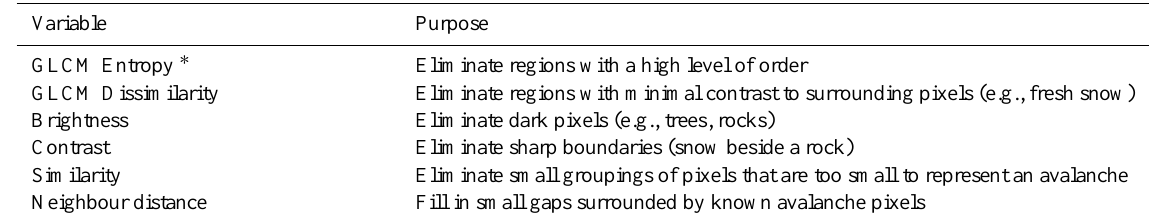
Table 2. Variables used in algorithm developed in eCognition for the automated detection and 249 mapping of snow avalanches in VHR panchromatic imagery. ( ∗ Variable only used on QuickBird 250